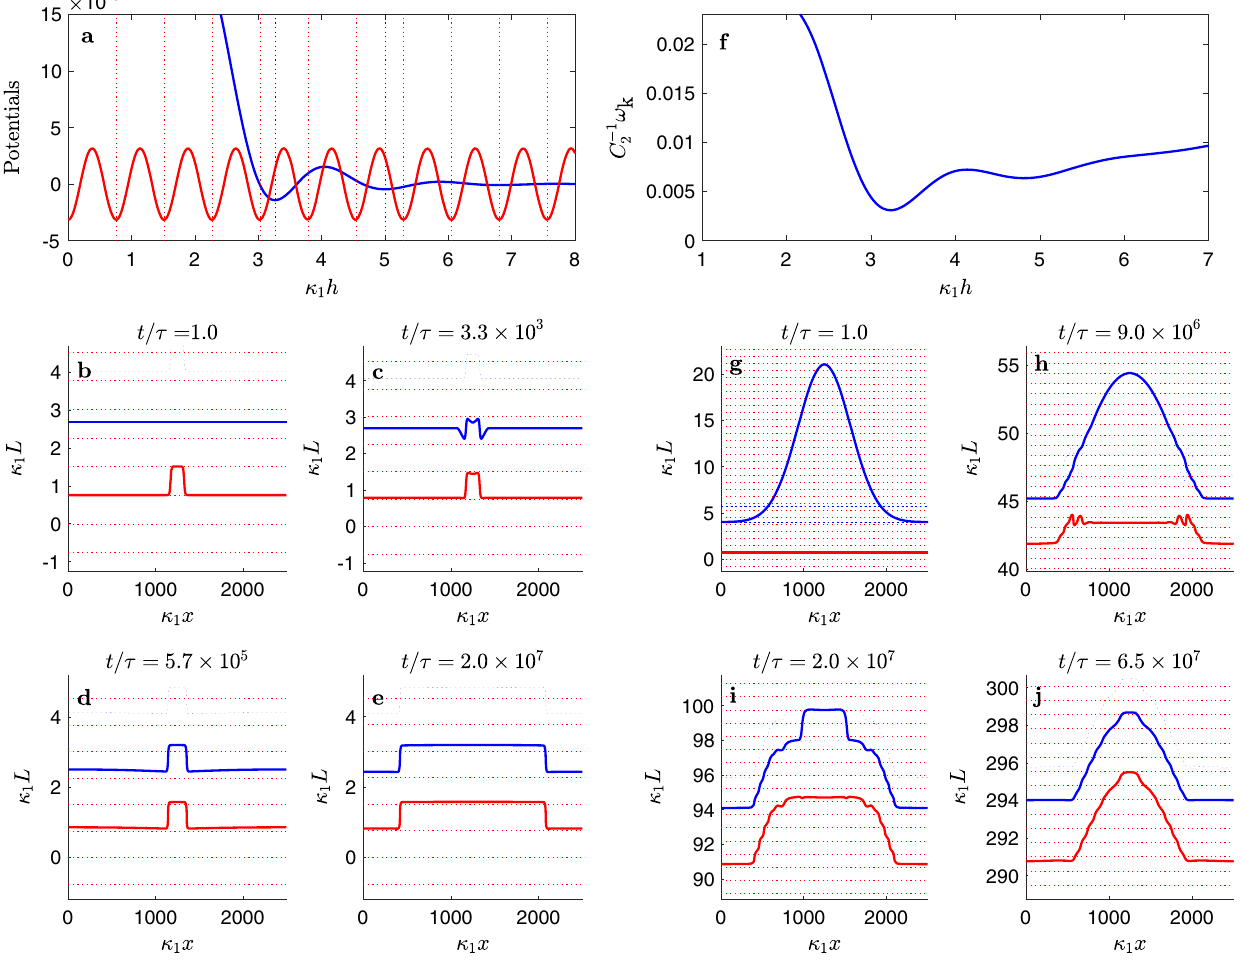
Fig. 4 Surface dynamics below the kinetic coexistence line. Panels a and f show the effective potentials for state points depicted as an asterisk ( (cid:1) ) and a circle ( (cid:3) ) in Fig. 3, respectively. Panels b – e and g – j show the corresponding solid/liquid and liquid/vapor surfaces at signi fi cant milestones in their time evolution (solid red and blue lines, respectively). The dashed red lines indicate the surface location for fully formed ice bilayers, and dashed blue lines show the heights of a premelting fi lm at the α or β minima, as a guide to the eye. Panels a – e illustrate the evolution in the nucleated regime at ( p , T ) = (455 Pa, 269.5 K) (marked as an asterisk ( (cid:1) ) in Fig. 3). Panel a shows the sine-Gordon and interface potential which dictates the surface dynamics. A small terrace nucleated on the solid/liquid surface (panel b ) triggers the formation of a similar terrace on the liquid/vapor surface (panel c ) and then spreads horizontally (panels d – e ). Once the surface has fl attened, further growth is not possible until a new terrace is nucleated (Supplementary Movie 1). Panels f – j illustrate the evolution of a droplet quenched to a pressure just below the kinetic liquid – vapor coexistence line at ( p , T ) = (514 Pa, 269.5 K) (shown as a circle ( (cid:3) ) in Fig. 3). The effective free energy, ω k ( h ), (panel f ) inhibits the growth of liquid wetting fi lms. A droplet (panel g ) triggers the formation of a terrace at the rim, which then spreads inside (panel h ) and grows to fi ll the droplet completely (panels i – j ). Subsequent growth occurs in a quasi-stationary state of constant fi lm thickness (Supplementary Movie